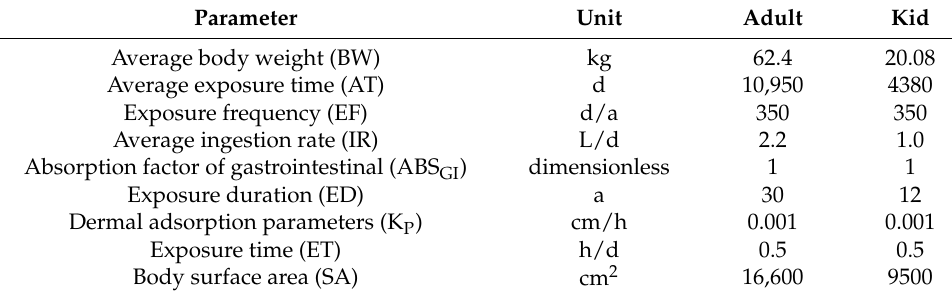
Table 1. Heavy metal exposure parameters